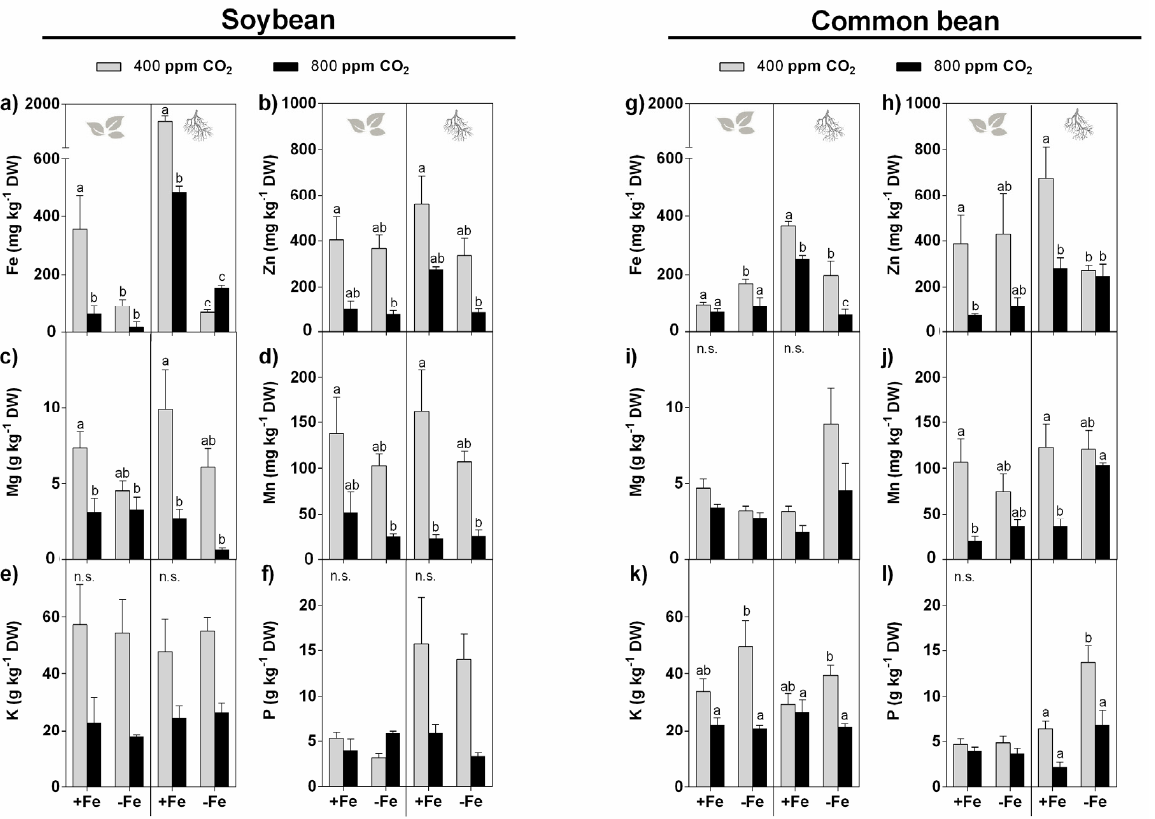
Figure 4. Concentrations of iron (Fe), zinc (Zn), magnesium (Mg), manganese (Mn), potassium (K) and phosphorous (P) in the leaves and roots of soybean ( left panel ) and common bean plants ( right panel ) grown at 400 ppm or 800 ppm CO 2 , under iron sufficiency, with iron at 20 µ M Fe-EDDHA (+Fe), and iron deficiency without Fe ( − Fe). The results represent the mean of five biological replicates ± SE. Different letters above bars indicate significant differences p < 0.05 using the Tukey test.